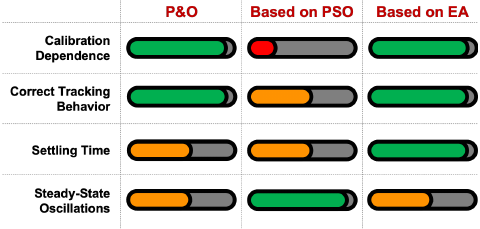
Figure 24. Performance comparison between the analyzed MPPT